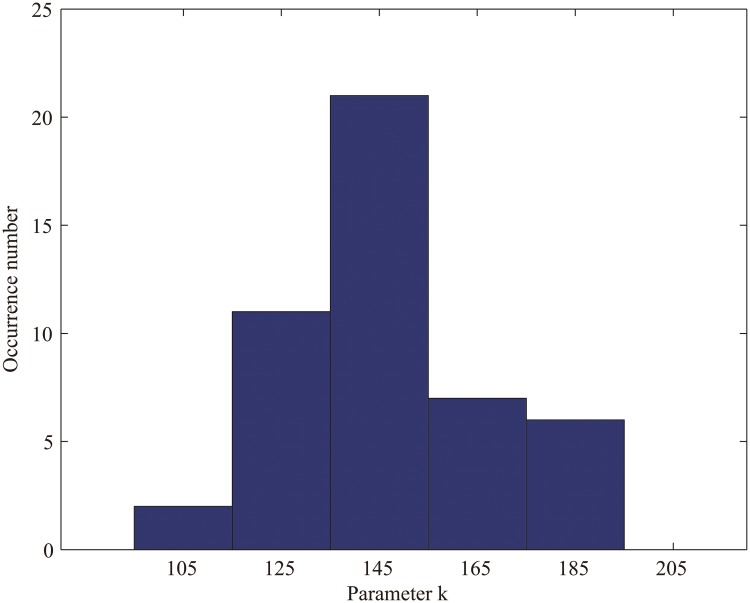
The distribution of numbers of selected features identified using the parameter search method in each fold.